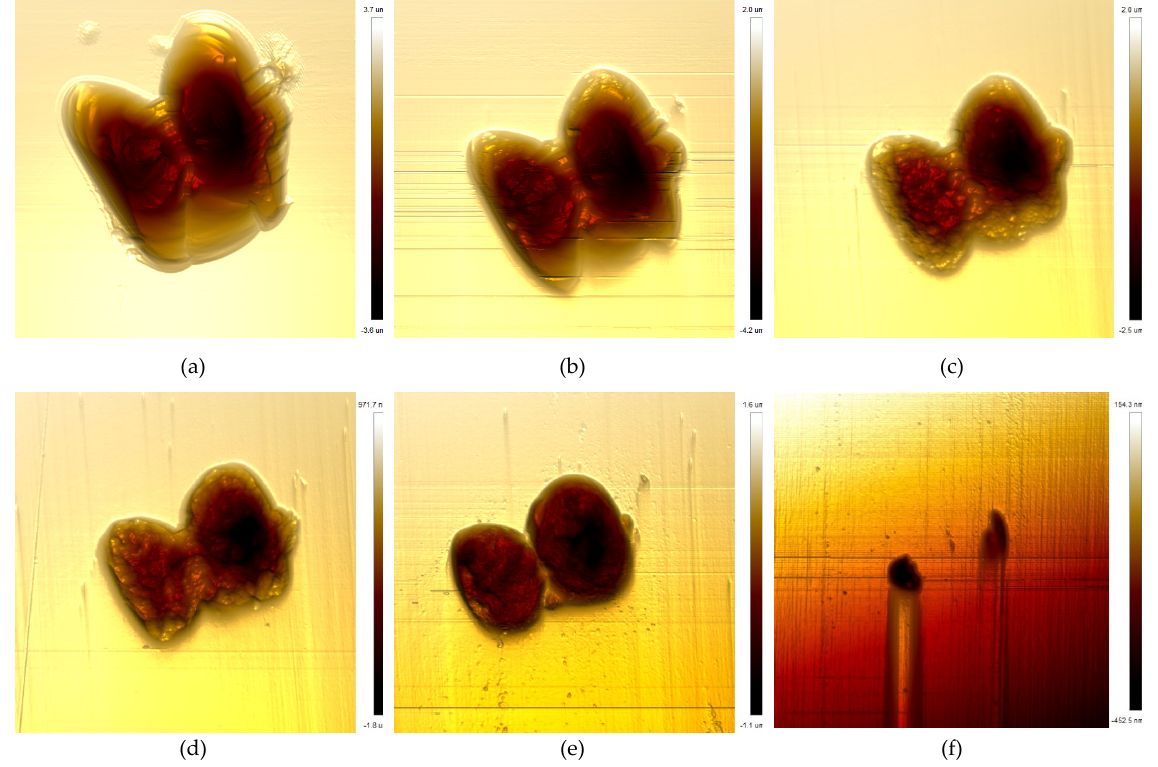
Figure 3. The images of damage morphology: ( a ) initial, 1272 nm RMS; ( b ) repair depth is 1 μ m, 971 nm RMS; ( c ) repair depth is 2 μ m, 610 nm RMS; ( d ) repair depth is 3 μ m, 373 nm RMS; ( e ) repair depth is 4 μ m, 374 nm RMS; ( f ) repair depth is 5 μ m, 20.9 nm RMS.